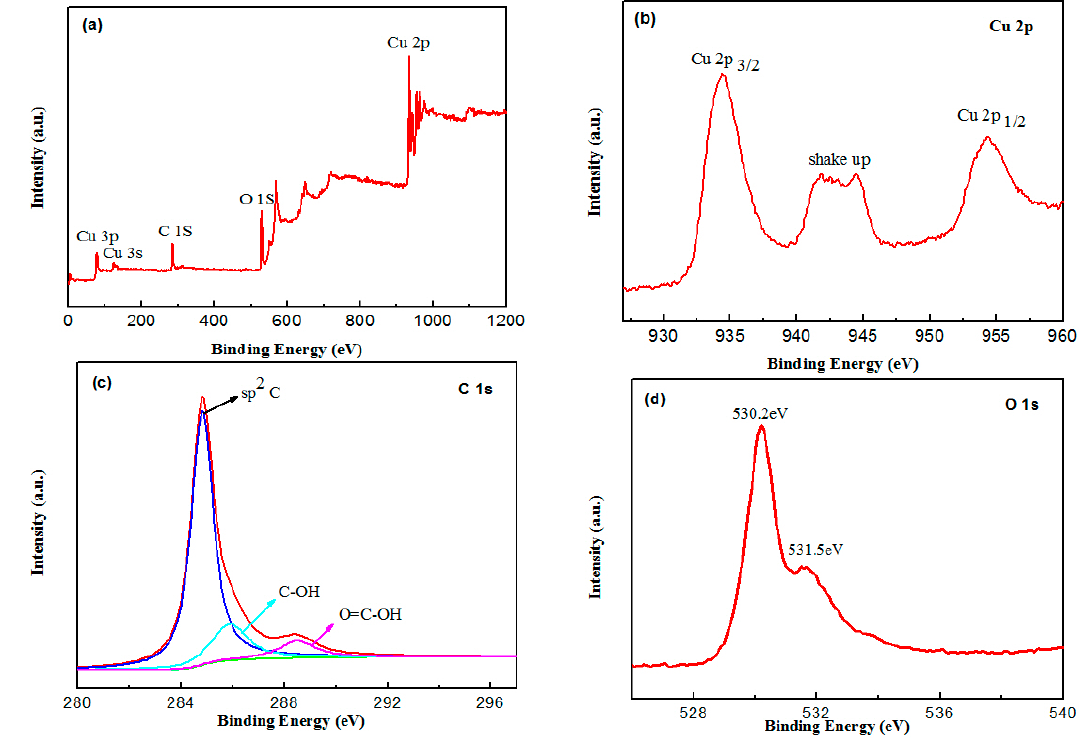
Figure 5. XPS analysis of the 10% ‐ RGO–CuO catalyst: ( a ) general scan; ( b ) Cu 2p spectrum; ( c ) C 1s spectrum; ( d ) O 1s spectrum.